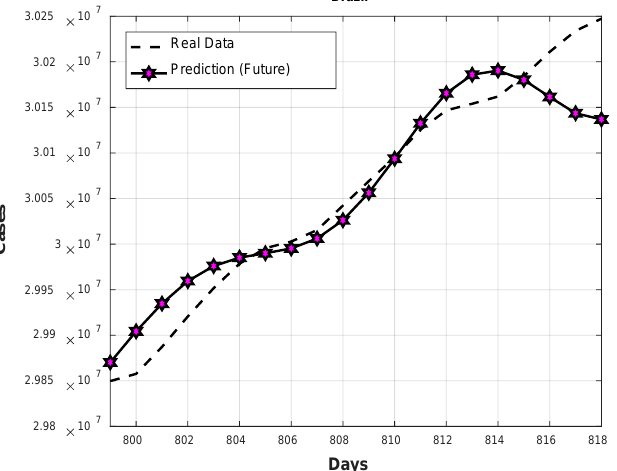
Figure 12. Best future prediction (Brazil).